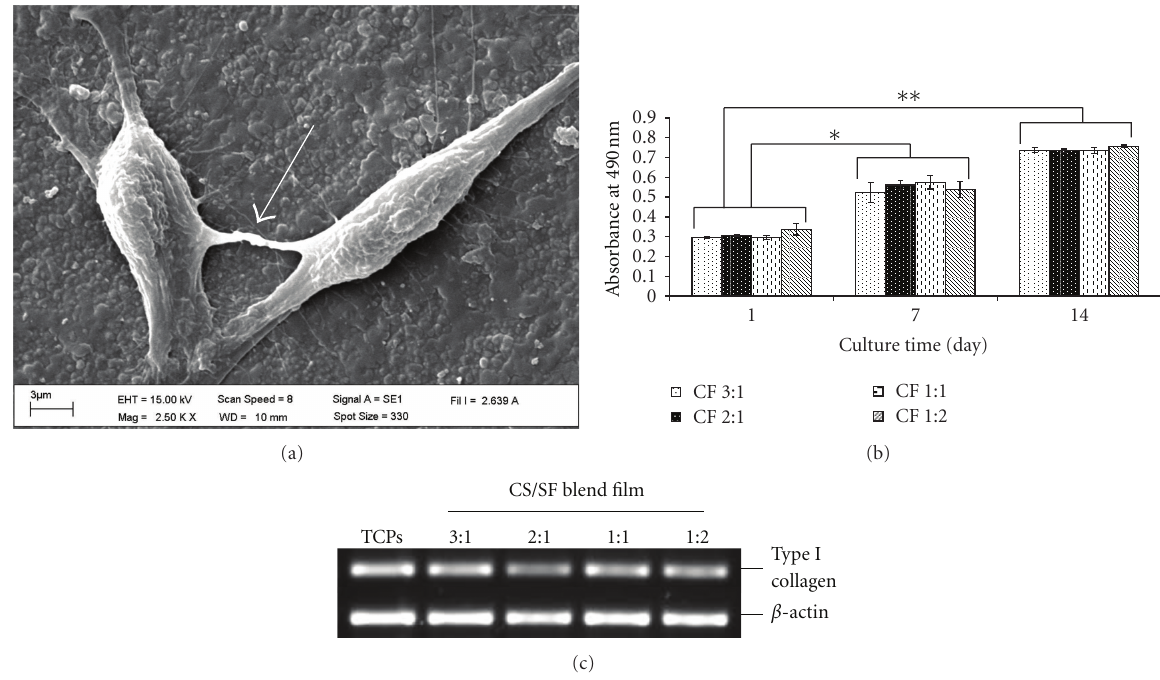
Figure 8: Biocompatibility of fibroblast cells on CS/SF blend films: (a) fibroblast cells adhesion on the blend film after 3 days of incubation, the white arrow showing cell-cell interaction, (b) fibroblast cells viability on the di ff erent blend films, and (c) type I collagen mRNA expression of fibroblast cells cultured on the blend films and tissue culture plate (TCPs) at day 14. Data represent mean ± standard error ( n = 4). Student’s t -test showed a significant di ff erence in day 7 ( ∗ P < 0 . 05) and day 14 ( ∗∗ P < 0 . 001) as compared to day 1 (CF: chitosan:fibroin